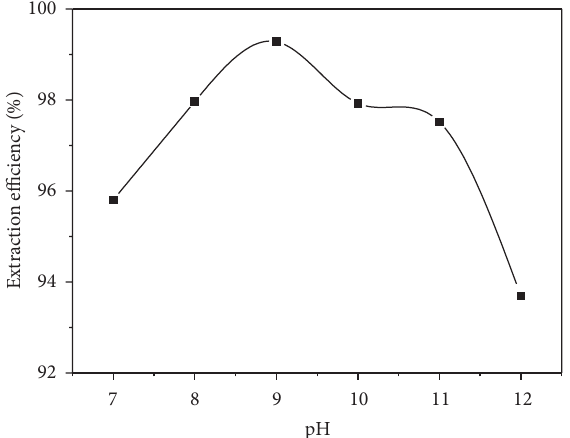
Figure 3: Effect of pH on the extraction efficiency of papain in [Bmim]Cl+K 2 HPO 4 aqueous two-phase systems at 25 ∘ C. aromatic residues of the proteins is a possible driving force for the partition of proteins.